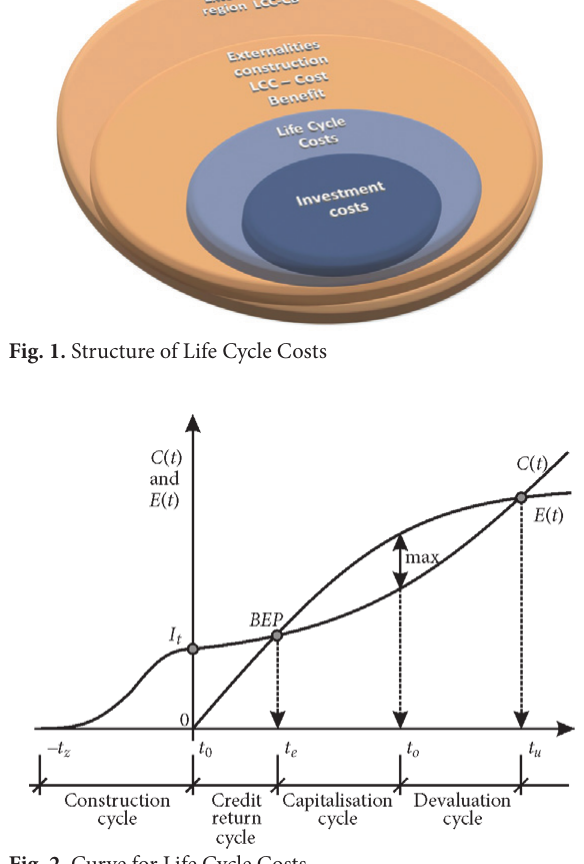
Fig. 2. Curve for Life Cycle